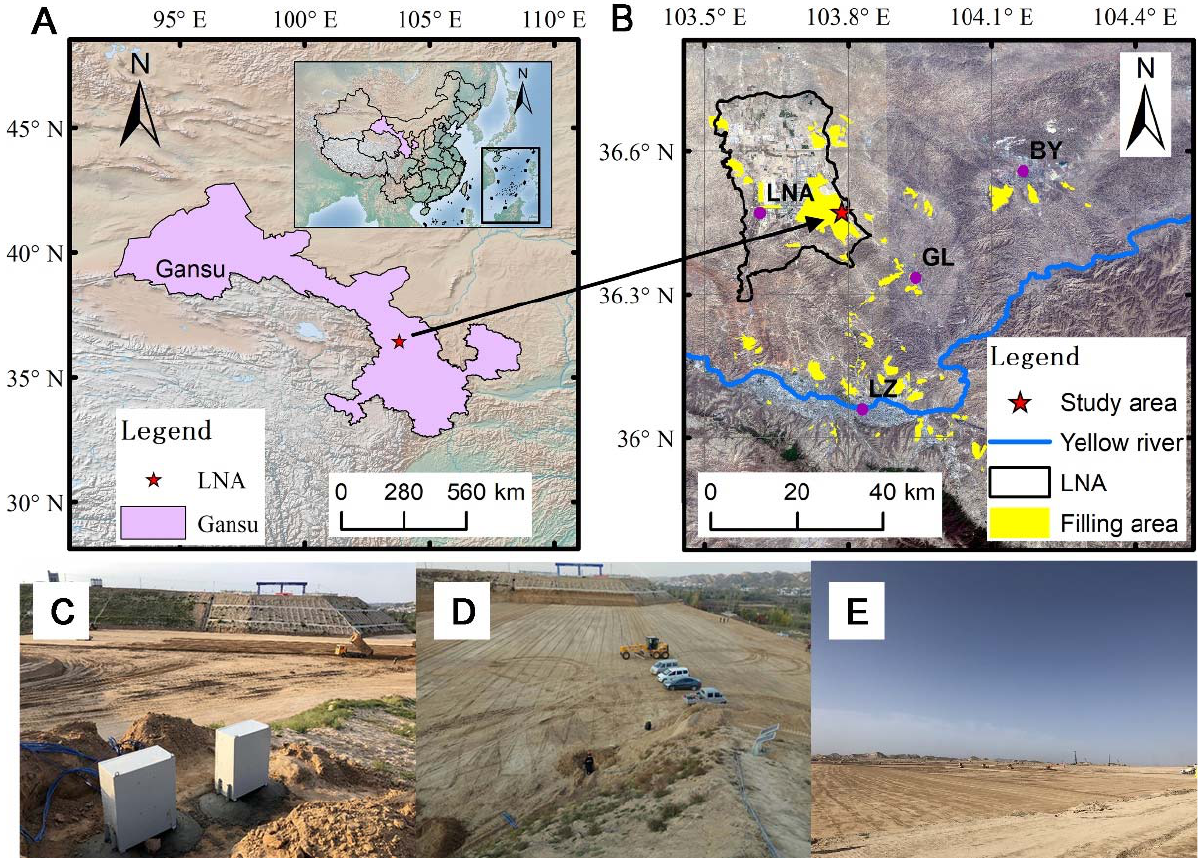
Figure 1. Study area and photos of different stages (( A ) is the location of the research area, ( B ) is the distribution of the filling areas in Lanzhou, ( C ) is a photo of our research area taken on 12 September 2018, ( D ) is a photo of our research area taken on 16 October 2018, and ( E ) is a photo of our research area taken on 6 June 2019. LZ: Lanzhou city, GL: Gaolan county, BY: Baiyin city).